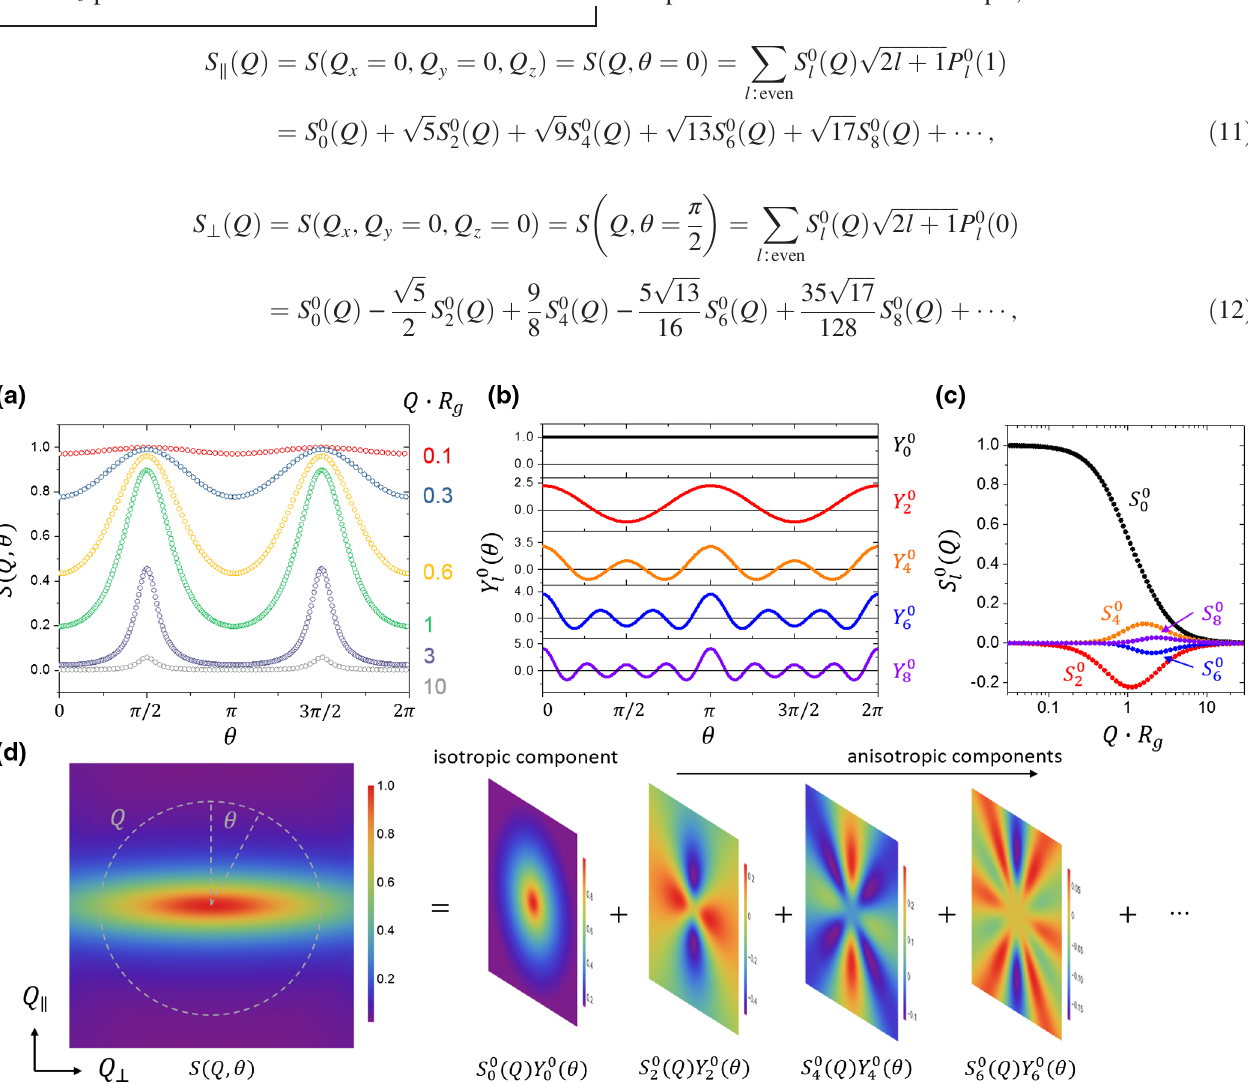
FIG. 2. Illustration of the spherical harmonic expansion approach with the simulated spectrum from the affine model, for a linear polymer that is uniaxially stretched to λ ¼ 3 . (a) Angular dependence of the anisotropic single-chain structure factor at various Q ’ s. (b) Angular dependence of the projections of the spherical harmonic functions on the xz plane. As we discuss in the text, these are ð Q Þ are given by Legendre expansion of S ð Q; θ Þ . (d) The essentially Legendre functions. (c) The Q -dependent expansion coefficients S 0 l spherical harmonic expansion decomposes the 2D SANS spectrum into contributions from different symmetries: the isotropic component S 0 0 ð Q Þ Y 0 0 ð θ Þ , and the anisotropic components S 0 2 ð Q Þ Y 0 2 ð θ Þ , S 0 4 ð Q Þ Y 0 4 ð θ Þ , S 0 6 ð Q Þ Y 0 6 ð θ Þ ,